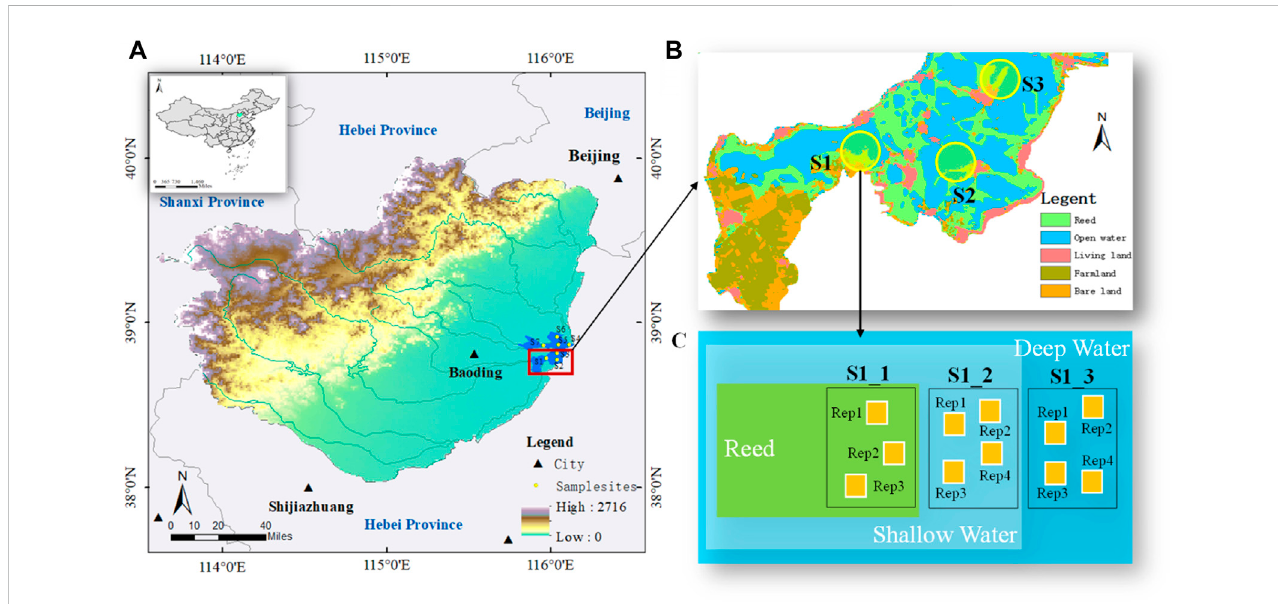
FIGURE 1 Location of Lake Baiyangdian (BYD, Figure 1A), seven sampling strips (Figure 1A; Figure 1B), and repetitions at each sample site (Figure 1C). As shown in Figure 1B, three sample sites were conducted in each sampling strip, where sampling strip S1 is consist of sample sites marked as S1_1, S1_2, and S1_3. And Rep1 to Rep4 showed the repetitions in each sample